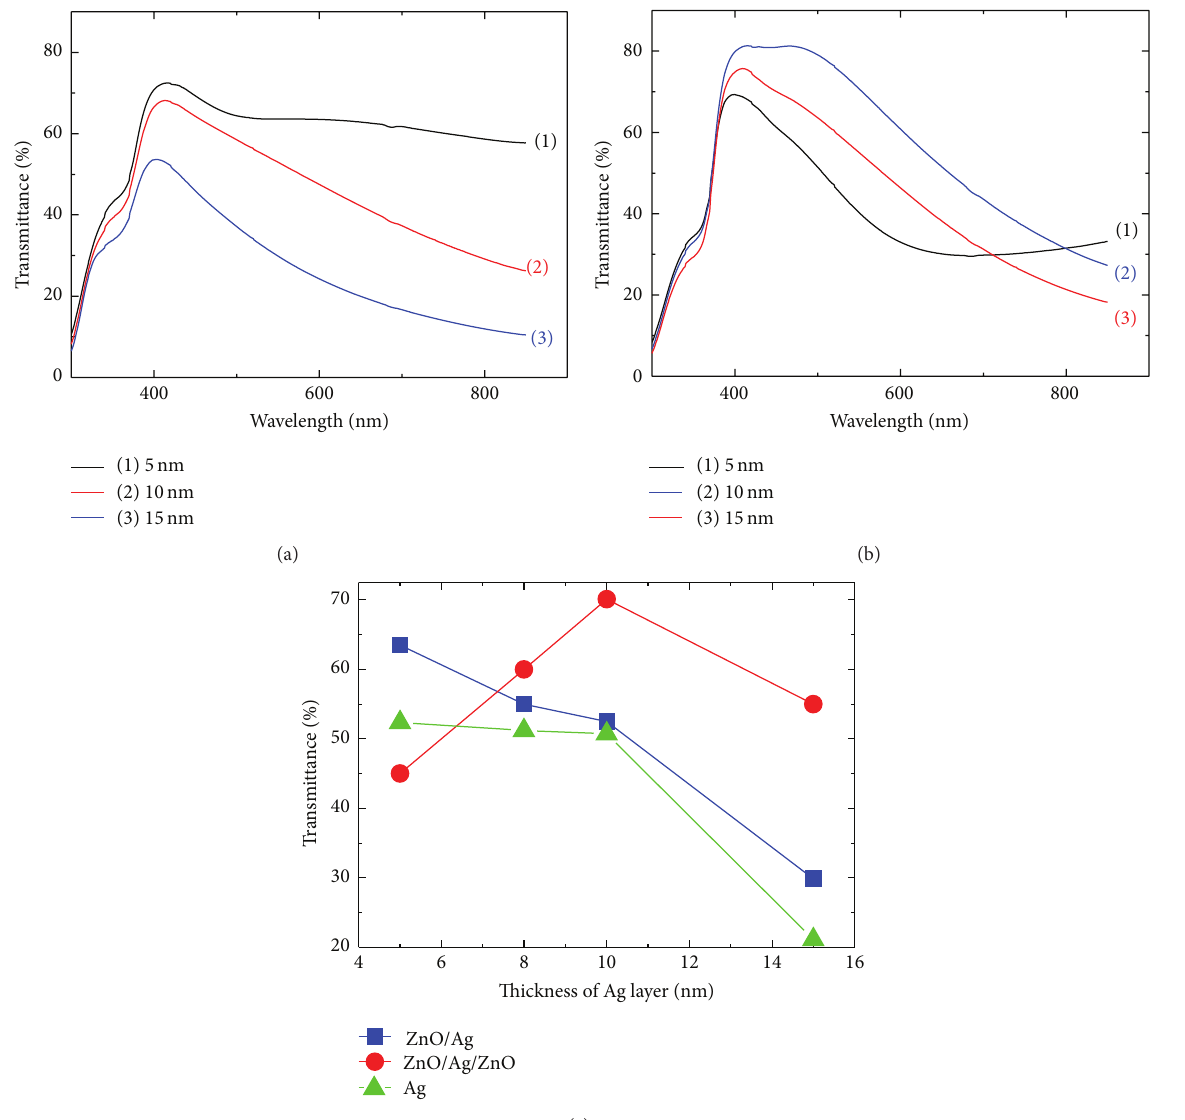
Figure5:Dependenceoftransmittanceof(a)AZand(b)ZAZonthethicknessoftheinsertedAgfilmsand(c)transmittanceatthewavelength of 550 nm of Ag, ZA, and ZAZ as a function of the Ag